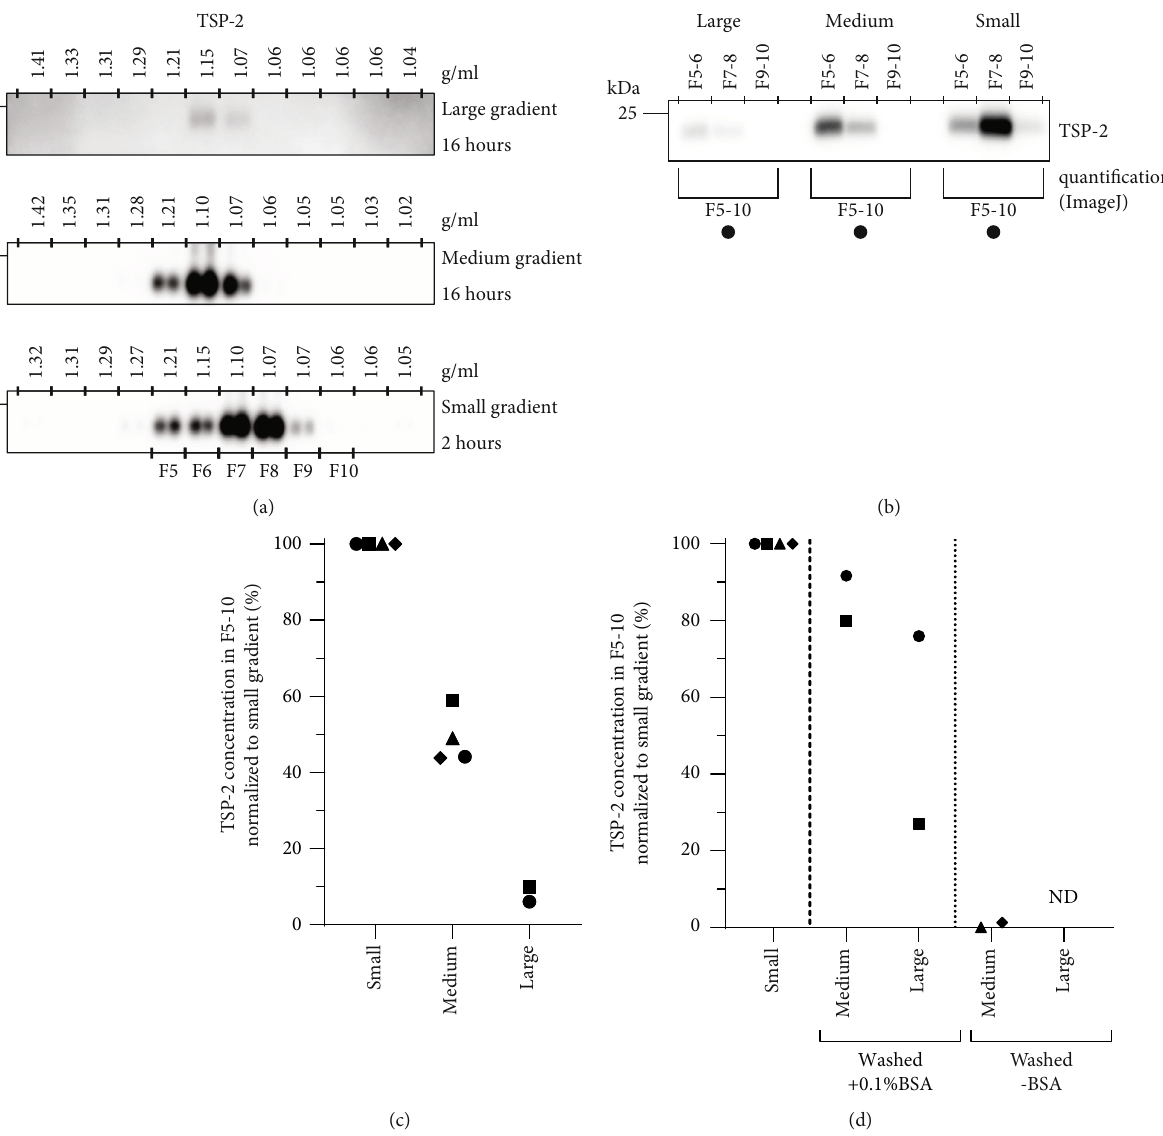
Figure 2: Comparative detection of adult worm EVs isolated with three di ff erent sizes iodixanol density gradients. (a) Western blot detection of tetraspanin-2 (TSP-2) in TCA precipitated protein isolates of fractions from adult worm EVs fl oated bottom-up into large (12 ml), medium (4.3 ml), or small (1.7 ml) iodixanol gradients. (b) Equal 100,000 × g EV-enriched pellets of the same adult worm cultures were loaded in the three di ff erently sized gradients. EV-containing fractions were pooled and directly mixed with sample bu ff er for SDS-PAGE to compare TSP-2 detection by western blot. (c) Quanti fi cation of TSP-2 band intensities of western blots in (b). (d) EVs in pooled fractions of medium and large gradients were diluted in PBS with or without 0.1%BSA, repelleted by UC, and concentrated to equal volumes as the small gradient fractions. TSP-2 levels in concentrated EV isolates from medium- and large-sized gradients were compared to EV isolates taken directly from the small density gradient. TSP-2 western blot and quanti fi cation were performed as in (b). Data in (a) and (b) is representative for 2-4 independent experiments. Each symbol in (c) and (d) corresponds to an independent